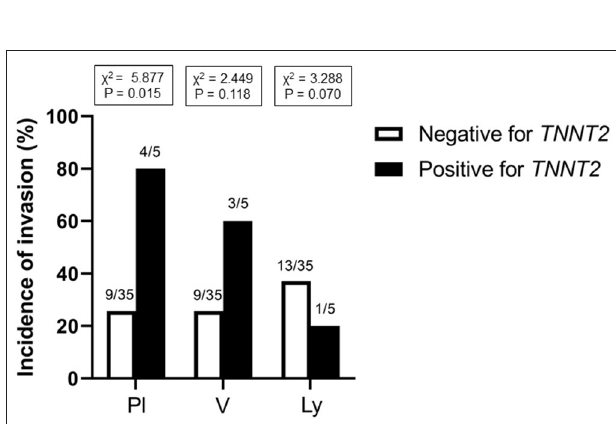
FIGURE 3 | Incidence of TNNT2 immunoreactive staining with pleural, vessel and lymphatic invasion in specimens performed surgical resection. Pl, pleura; V, blood vessel; Ly, lymphatic